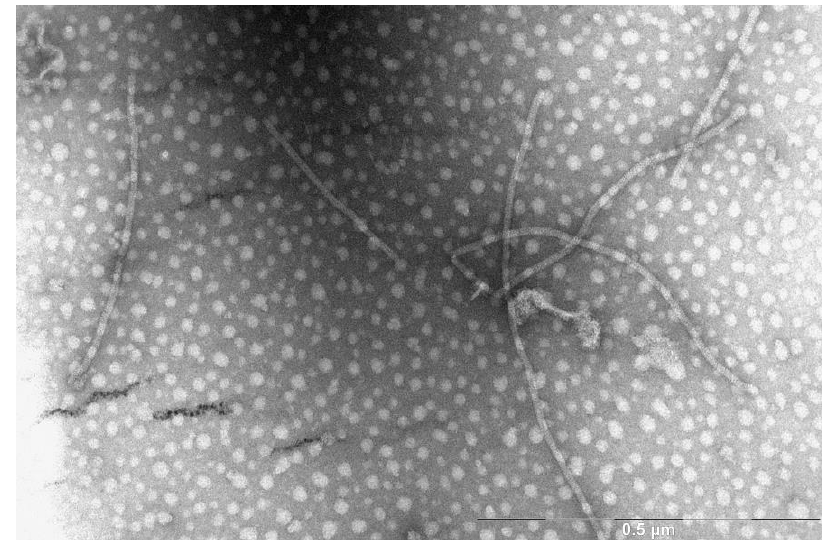
Figure 1. Electron micrograph of BYV isolated from T. tetragonioides.